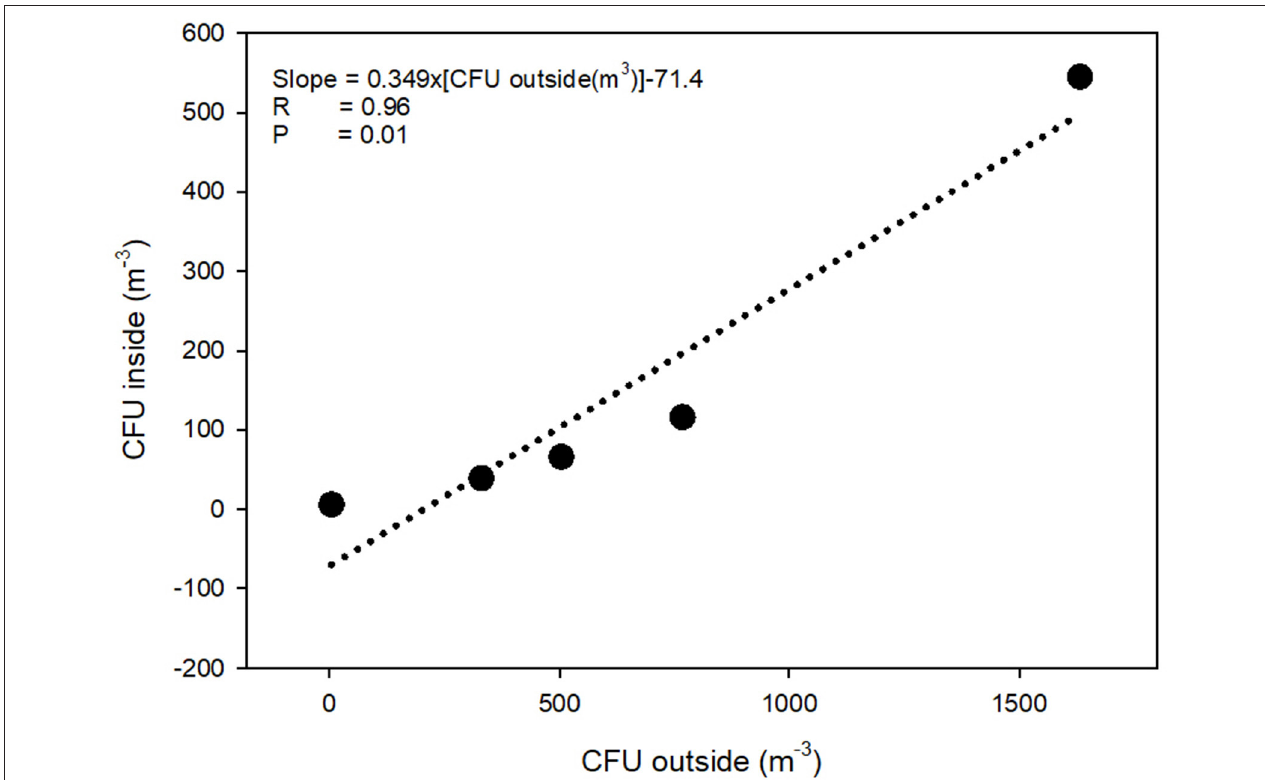
FIGURE 2 | Concentration of airborne LA-MRSA measured inside and from the ventilation shaft outside a swine farm. Data on the two axes are measured by different methods: Gelatine filters (inside) and PBS collection (outside). CFU, Colony Forming Units; R, Pearsson’s correlation coefficient.